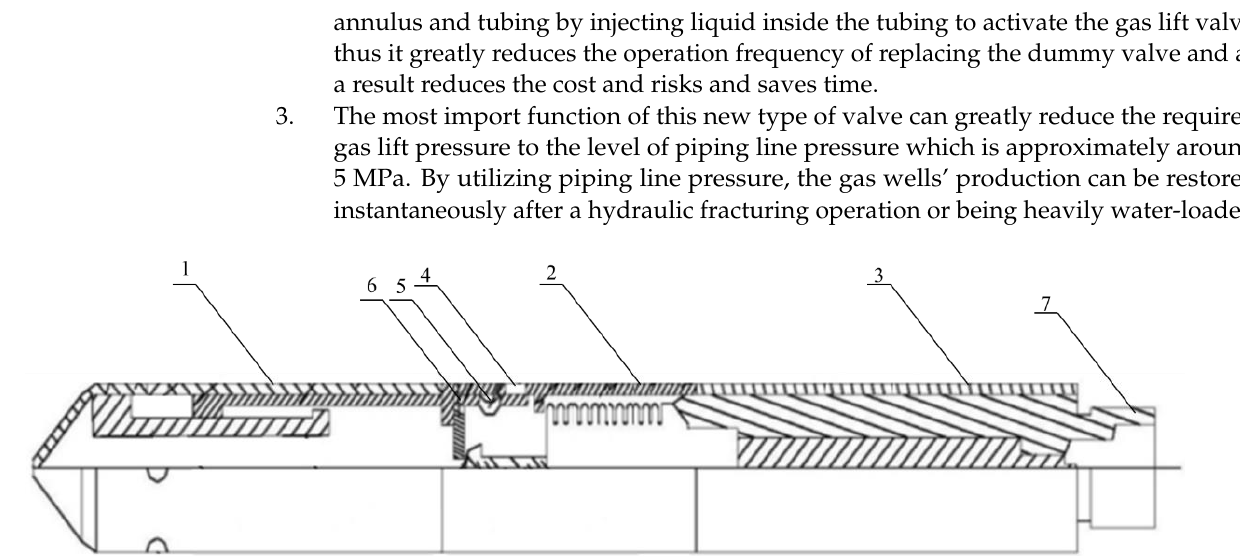
Figure 4. New type of fixed gas lift valve structure.